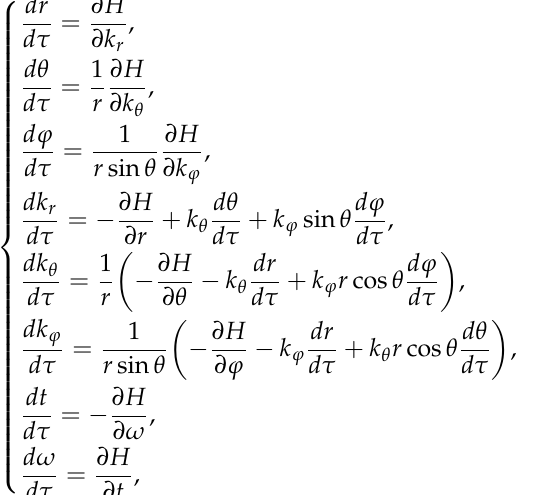
density. Figure A1 shows the schematic diagram of the gridded matrix model, where the yellow dashed arrow indicates the ray path from the HF source. Each gridded